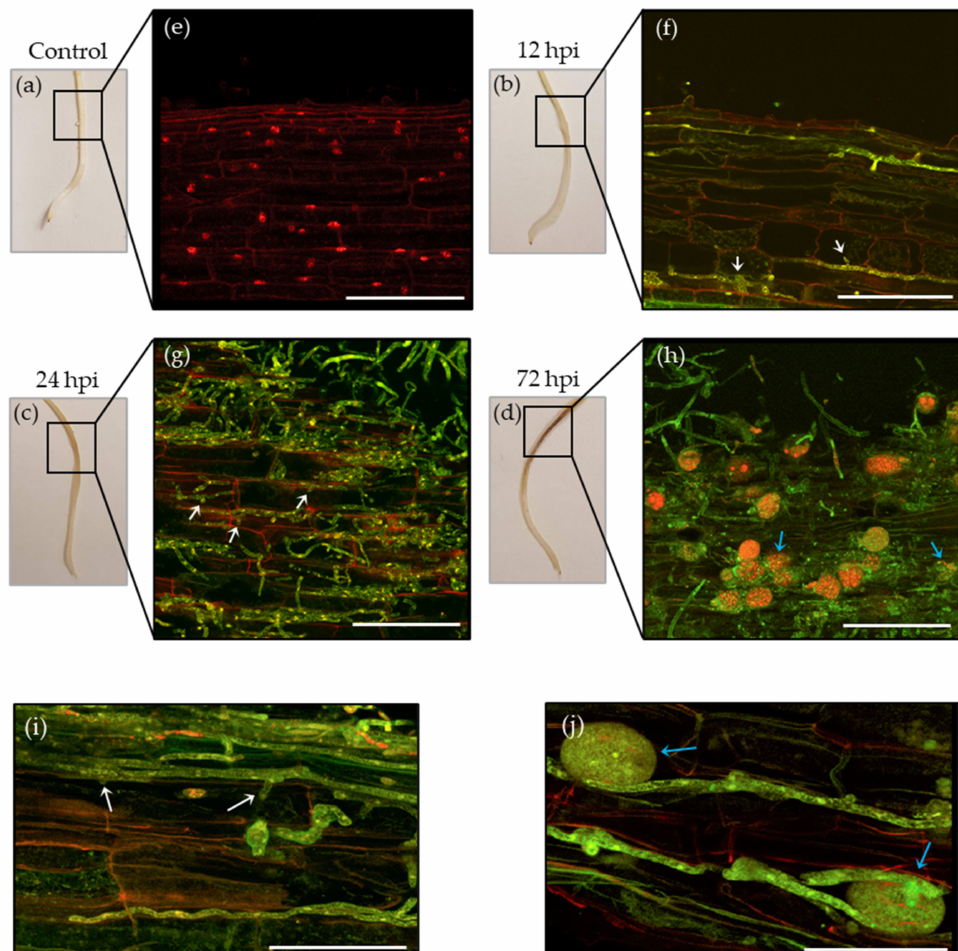
Figure 1. Phytophthora medicaginis pathogenesis is associated with a fast rate of necrosis and hemibiotrophic development. ( a – d ) Macroscopic symptoms of chickpea var. ‘Sonali’ either mock- inoculated with pathogen free agar blocks (control) or 12, 24 and 72 h post-inoculation (hpi) with P. medicaginis isolate 7831. ( e – h ) Confocal microscopy images of the 0.5 cm root segment that was sampled either from a mock-inoculated control or from the P. medicaginis inoculated site at 12, 24 and 72 hpi (sampled segment denoted by a black box). P. medicaginis hyphae are observed by green fluo- rescence while root cell walls are observed by red fluorescence. Intracellular haustoria development are indicated with white arrows while intracellular and extracellular chlamydospores are indicated by blue arrows. ( i ) Confocal microscopy images showing close up of P. medicaginis haustoria (white arrows) and ( j ) chlamydospores (blue arrows) photographed at 12 and 72 hpi, respectively. Scale bars: ( e , f ) 150 µ m; ( g , h ) 1100 µ m; ( i ) 70 µ m; ( j ) 60 µ m. The confocal microscopy images were taken using a TCS SP5 confocal laser scanning microscope. For imaging, a Z-stack was taken of the inoculated site using whole-roots roots for ( e , h – j ), whereas 30 µ m in thickness longitudinal sections of cortical cell layer were imaged at the inoculated site for ( f , g